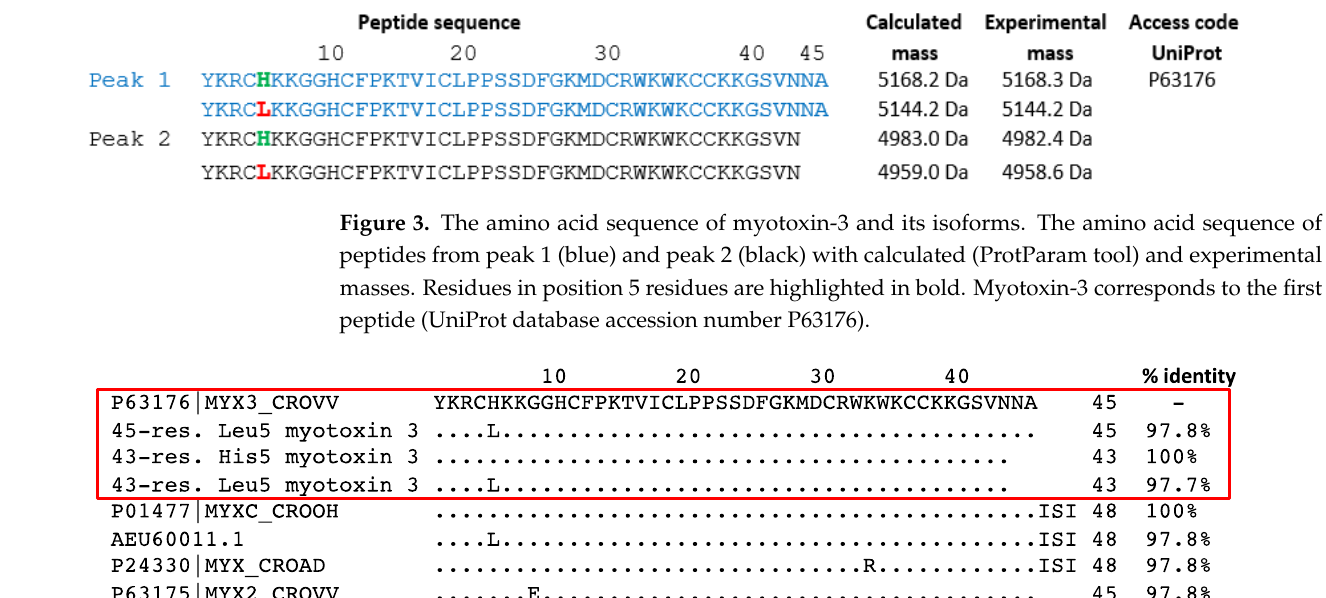
Figure 3. Alignment of the amino acid sequence of myotoxin-3 with homologous peptides. The amino acid sequences from this paper are in a red box. †: Salazar et al . 2020 (ref. [15]). The other sequences were obtained from the UniProtKB/SwissProt database. Dots indicate identities to myo- toxin-3 (P63176|MYX3_CROVV), asterisks (*) indicate identical amino acid residues and the sym- bols “:” indicate conserved substitutions.